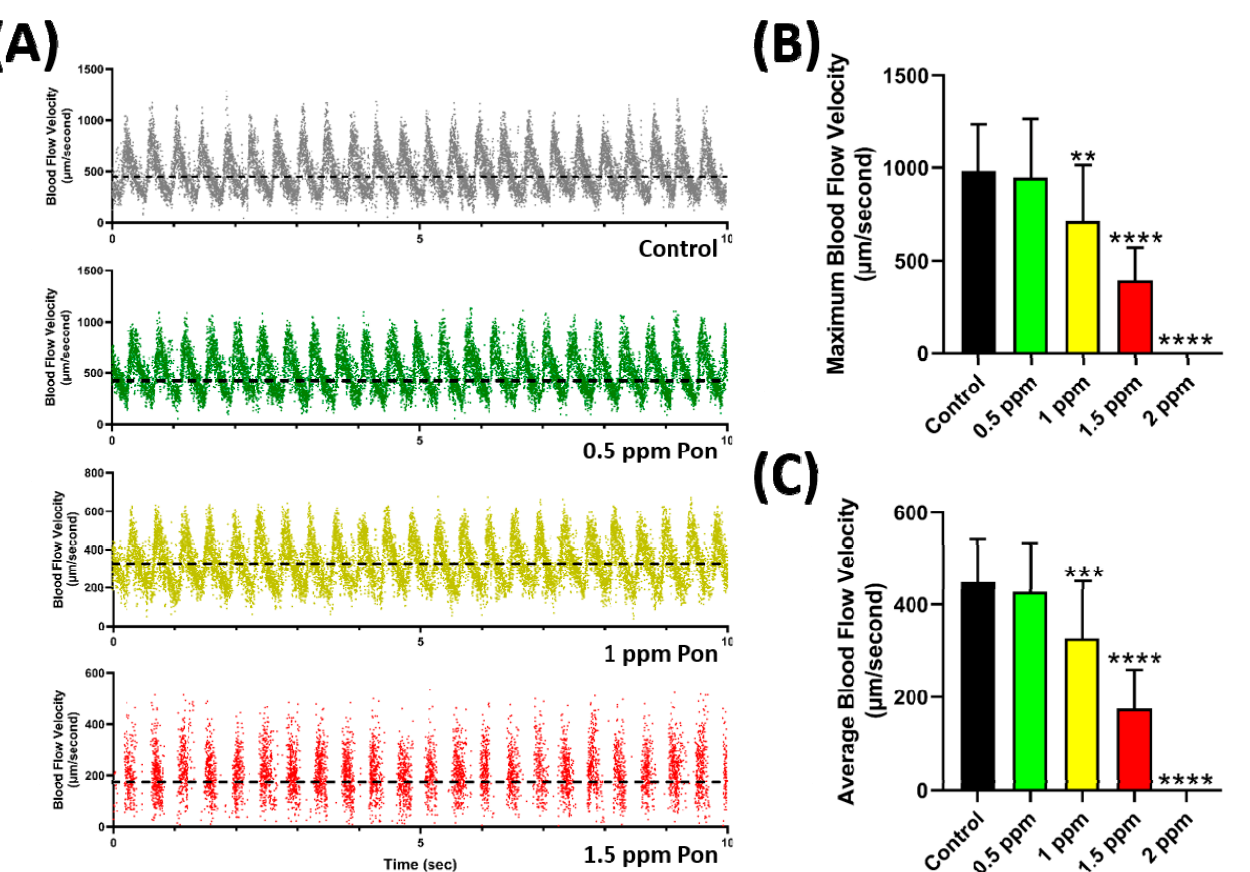
Figure 5. Representative of zebrafish larvae blood flow oscillation pattern after incubation in 0.05% DMSO (grey), 0.5 (green), 1 (yellow), and 1.5 (red) ppm of PON (dash line show the average velocity) ( A ). Maximum ( B ) and average ( C ) blood flow velocity in the dorsal aorta of zebrafish larvae after exposure to PON. Data are presented as mean ± standard deviation, and the statistical significance was calculated using ordinary one-way ANOVA with Dunnet multiple comparison test. (** p < 0.01, *** p < 0.001, **** p < 0.0001).